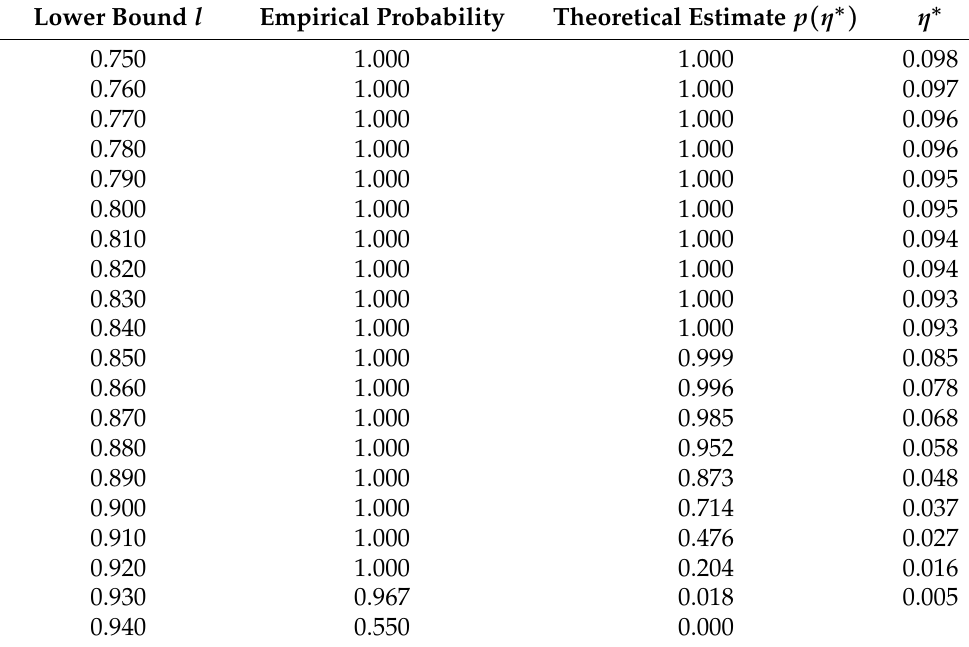
Table 1. Simulation results for B(0.1, 100), number genes = 20,000, proportion significant = 0.1, real power limit =